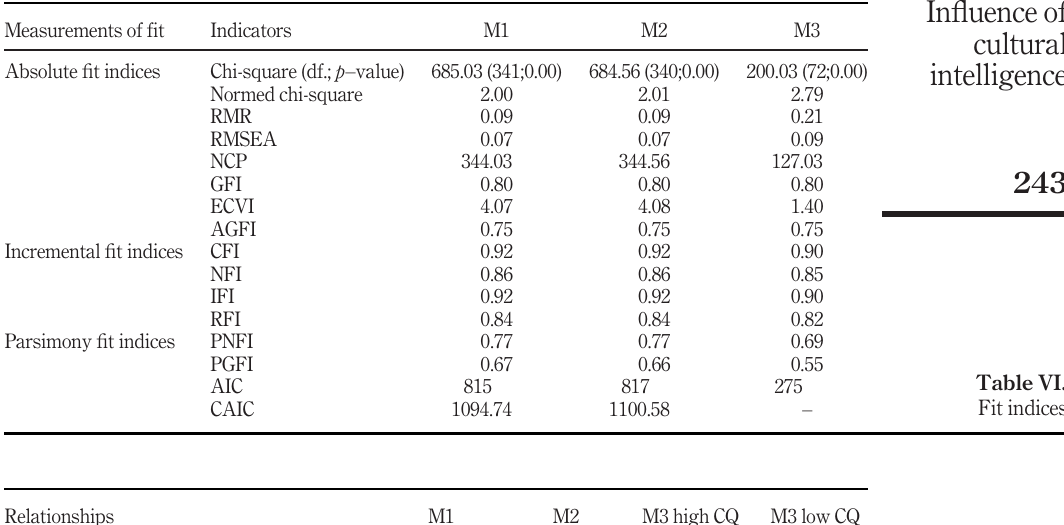
Table VII. Relationships subject to analysis in the